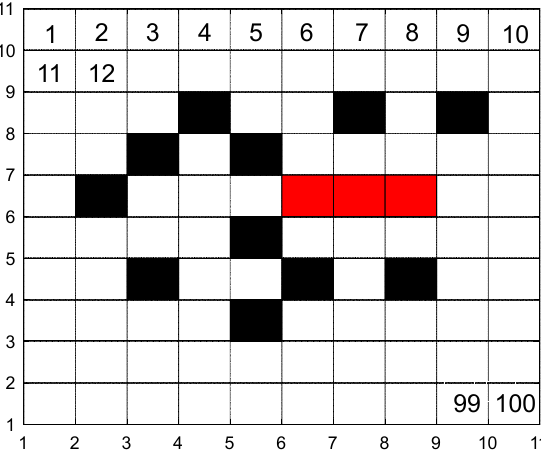
Figure 1. Schematic diagram of the grid.